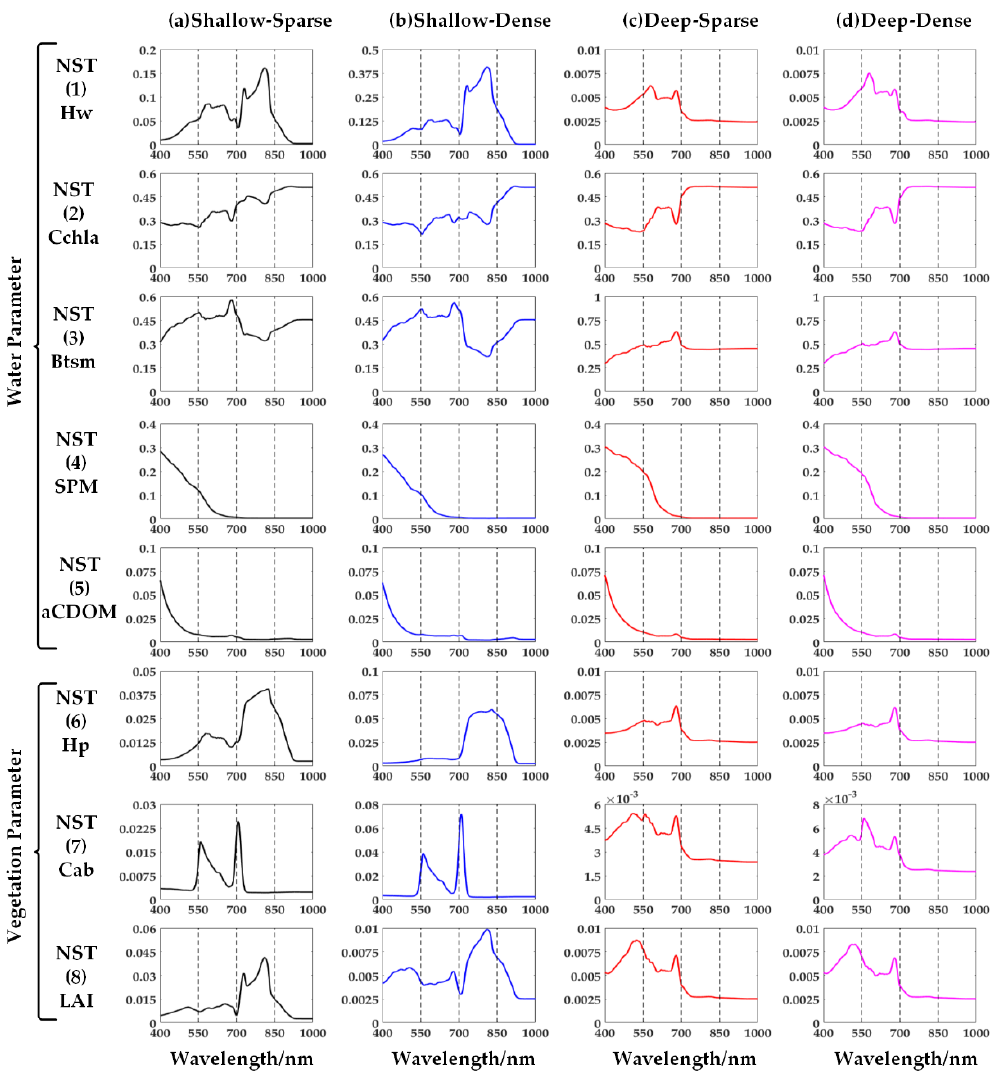
Figure 6. In four different cases, the curves of high sensitivity parameters varying with wavelength. The columns ( a ), ( b ), ( c ), ( d ) represent the case of shallow-sparse, shallow-dense, deep-sparse and deep-dense, respectively. (1)–(9) represent the high sensitivity parameters of the model, (1): The height of the upper water layer (Hw), (2): Concentration of chlorophyll a, in water (Cchla), (3): Coefficient to calculate scattering of total suspended matter (Btsm), (4): Concentration of suspended matter (SPM), (5): Absorption coefficient of CDOM at 375 nm (aCDOM), (6): Plant height (Hp), (7): Concentration of chlorophyll a+b (Cab), (8): Leaf area index (LAI).